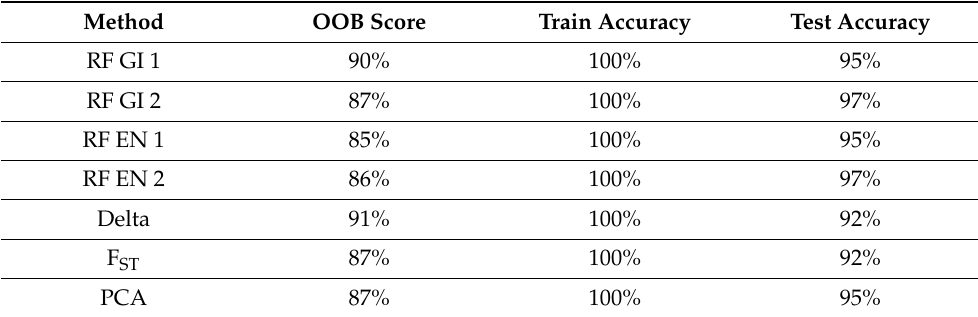
Table 2. Out Of Bag (OOB) and the accuracy classification scores obtained by RF algorithm consider- ing the reference and the test trout populations by using the seven 96 SNP panels.